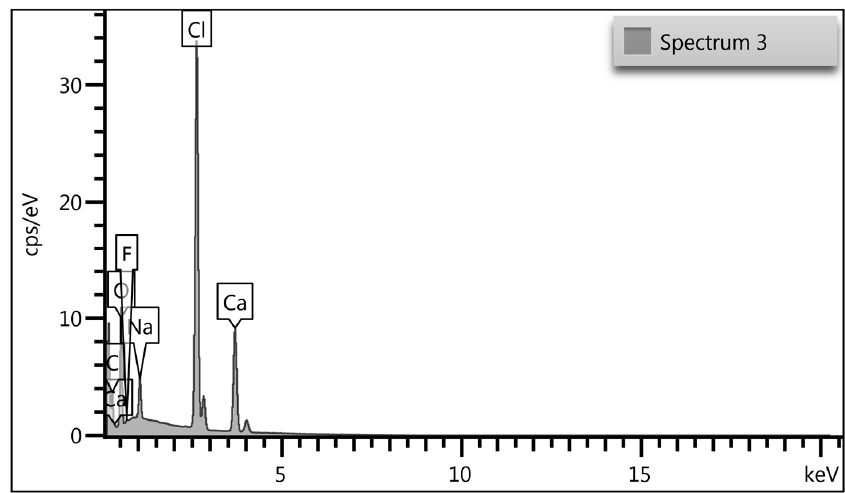
Figure 11. EDX spectrum of the sample (ALG-PFC) net .